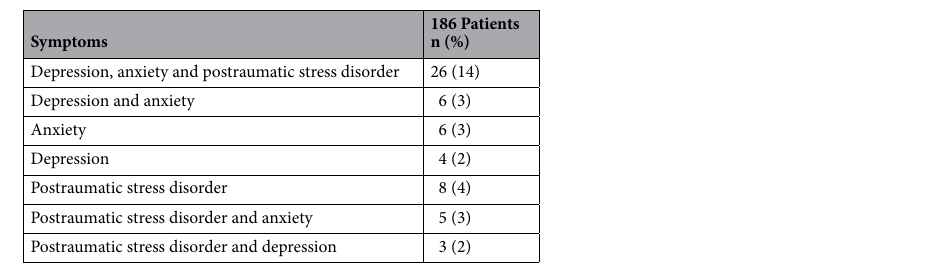
Table 4. Psychiatric